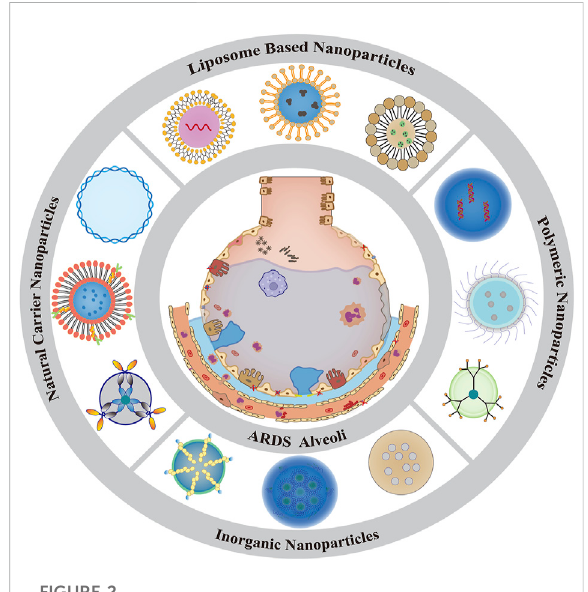
FIGURE 2 Summary graph of the current common classi fi cation of nanodrug delivery